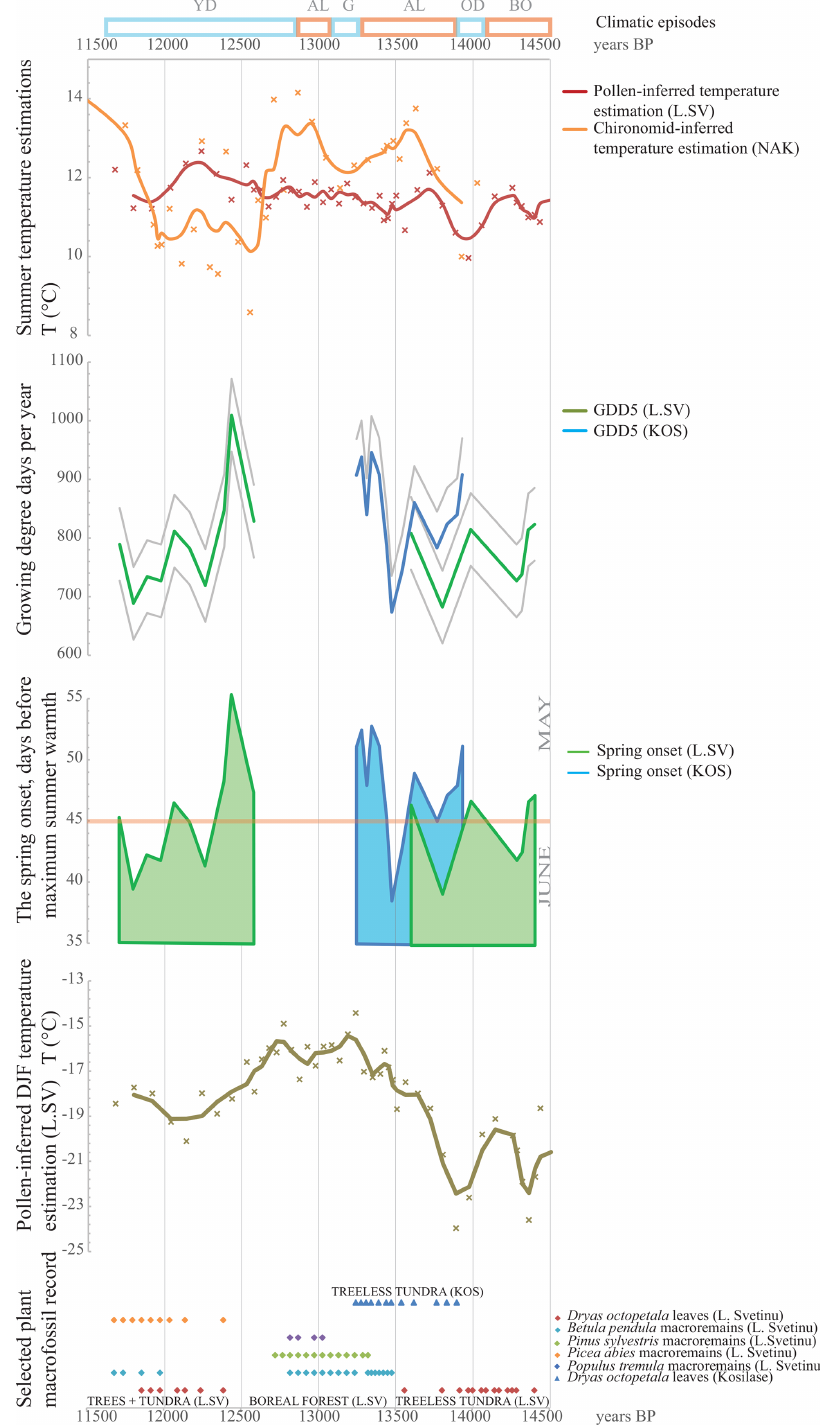
Figure 4. The compilation of Late Glacial vegetation and climate proxies from the study region: selected plant macrofossil records of Lakes L. Svetinu (L.SV) (Veski et al., 2012) and Kosilase (KOS), pollen-based May–June–July–August (MJJA) and December–January– February (DJF) temperature estimations of Lake L. Svetinu (Veski et al., 2015), chironomid-based July temperature estimation of Lake Nakri (location 1 in Fig. 1) (Heiri et al., 2014), the spring onset and growth-degree-day dynamics. The Late Glacial climatic episodes follow Rasmussen et al. (2014): (GS-1 ( ∼ 11650–12850calyrBP), Younger Dryas, YD; GI-1a ( ∼ 12850–13050calyrBP), Allerød, AL; GI-1b ( ∼ 13050–13250calyrBP G), Gertsenzee oscillation; GI-1c ( ∼ 13250–13900calyrBP), Allerød, AL; GI-1d ( ∼ 13900–14050calyrBP), Older Dryas, OD; GI-1e ( ∼ 14050–14650calyrBP), Bølling, BO. Clim. Past, 18, 2143–2153,